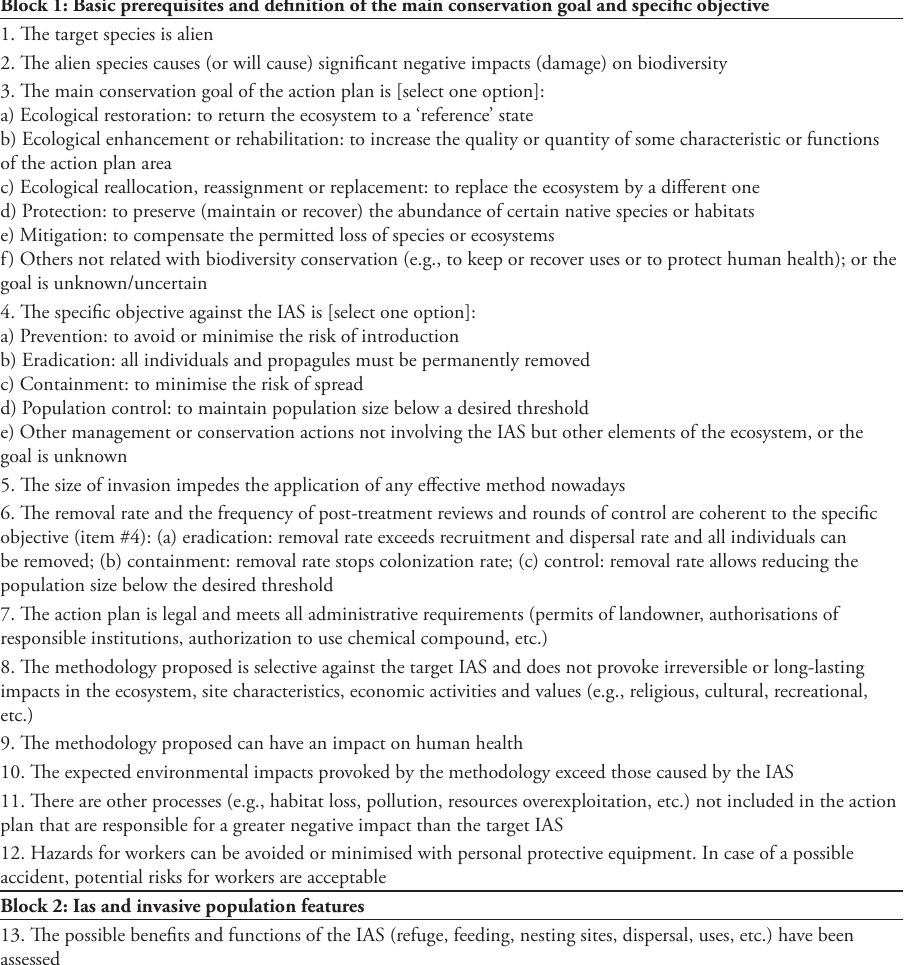
Table 1. Checklist for identifying deficiencies of actions for management of invasive alien species (IAS) in the field aimed to biodiversity conservation. The items must be answered in the framework of the action plan area. For assessments, the proposed methodology is defined by the elimination technique (biological, mechanical, chemical), the time or season of application, the number of applications, the final concen- tration (in case of a biocide), the frequency of monitoring and rounds of control, and methodological adaptations to minimise the impact and to promote ecosystem